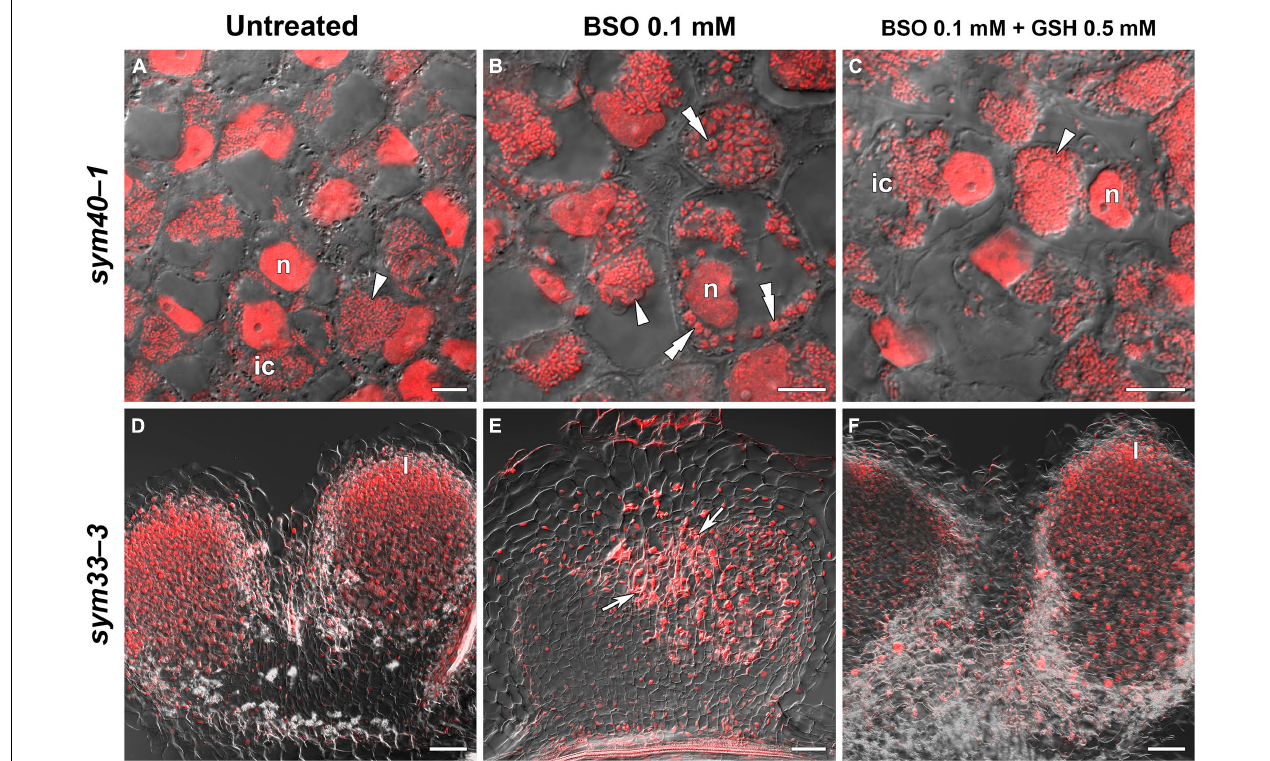
FIGURE 9 | Two-week-old nodules from mutant ( sym40-1 and sym33-3 ) pea ( Pisum sativum ) plants treated with L-buthionine-sulphoximine (BSO) and glutathione (GSH). (A–C) Cells of sym40-1 nodules; (D–F) general view of sym33-3 nodules; (A,D) untreated nodules; (B,E) nodules on plants treated with 0.1 mM BSO; (C,F) nodules on plants treated with 0.1 mM BSO and 0.5 mM GSH. Confocal laser scanning microscopy images of 50- µ m-thick longitudinal sections. Merge of differential interference contrast and the red channel. A single optical section is presented, DNA (bacteria and nuclei) is shown in red. I, meristematic zone; n, nucleus; ic, infected cell. Arrowheads indicate infection droplets; double arrowheads indicate abnormal symbiosomes containing several bacteroids; arrows indicate a zone of propagation of “locked” infection threads. Scale bars = 10 µ m (A–C) and 100 µ m (D–F)